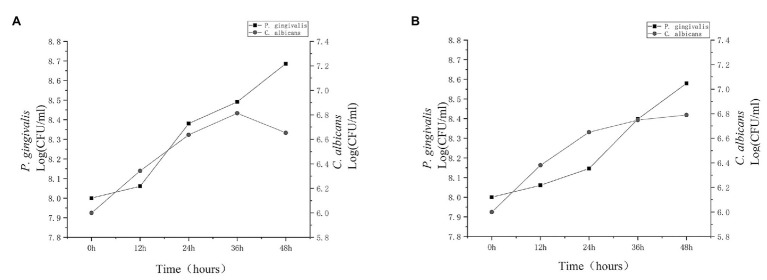
Population dynamics of Candida albicans and Porphyromonas gingivalis. Porphyromonas gingivalis and C. albicans single-species biofilms and P. gingivalis-C. albicans dual-species biofilm were cultured for 48 h. Growth dynamics of C. albicans (circles) and P. gingivalis (squares) were observed in (A) cocultures and (B) monocultures for 12, 24, 36, and 48 h. Growth was based on colony-forming units (CFU). After 36 h, the activity of C. albicans in the dual-species biofilm clearly decreased.